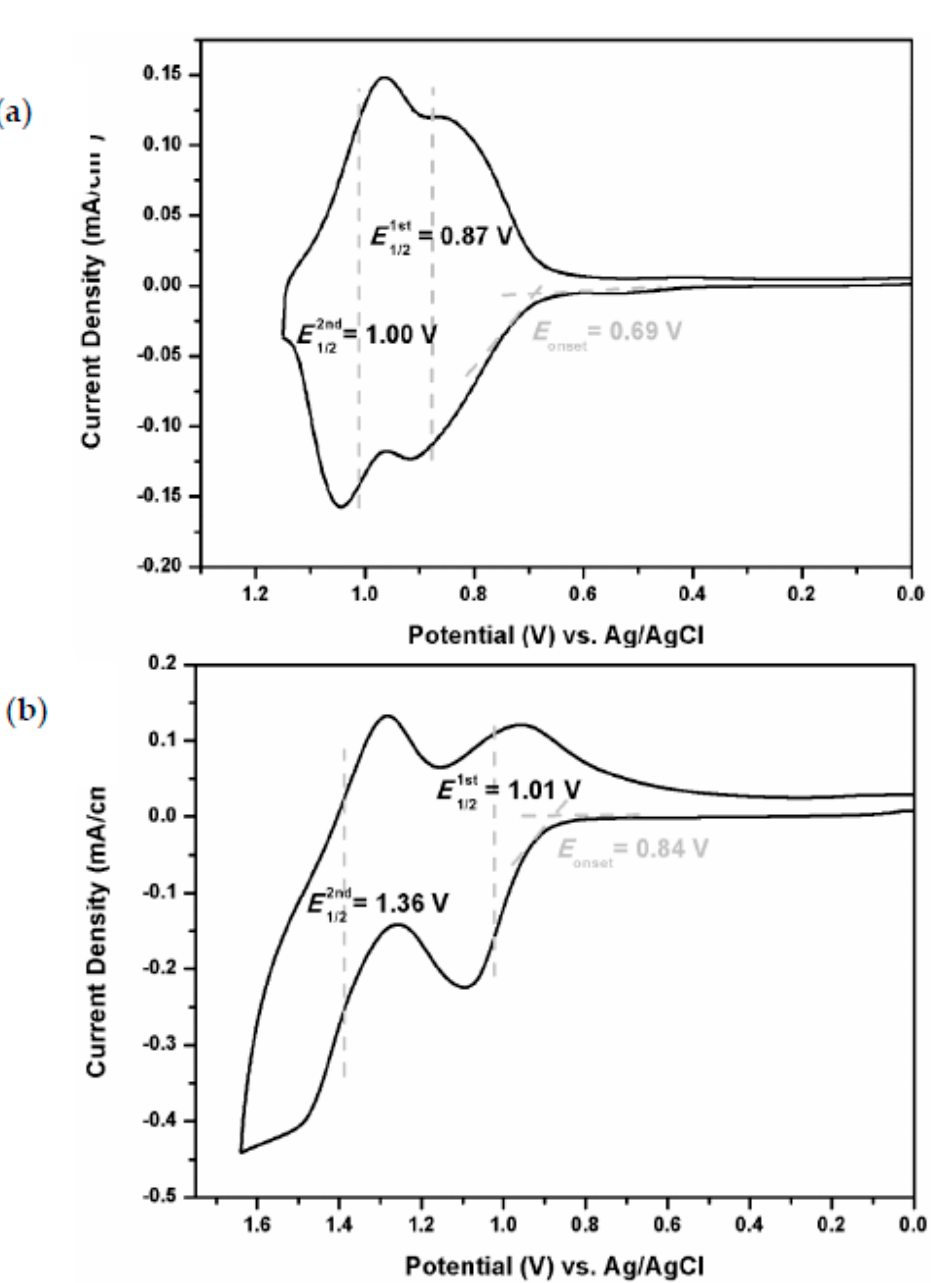
Figure 14. Cyclic voltammograms of ( a ) TPA–TPPI and ( b ) NPC–TPPI films on the ITO-coated glass slide.